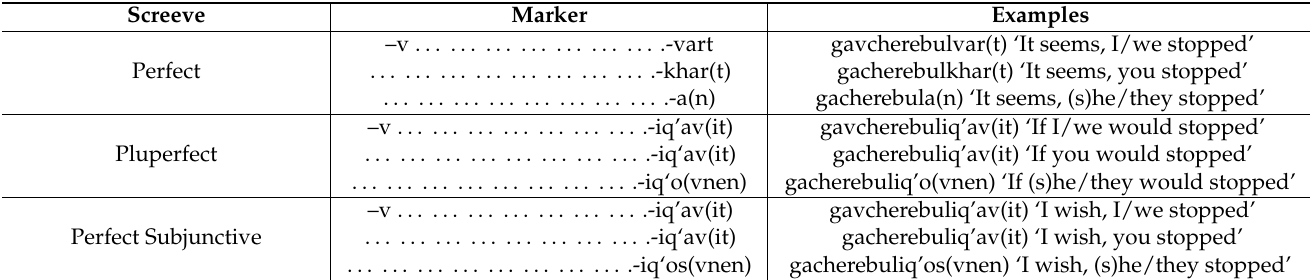
Table 7. Auxiliary verbs in